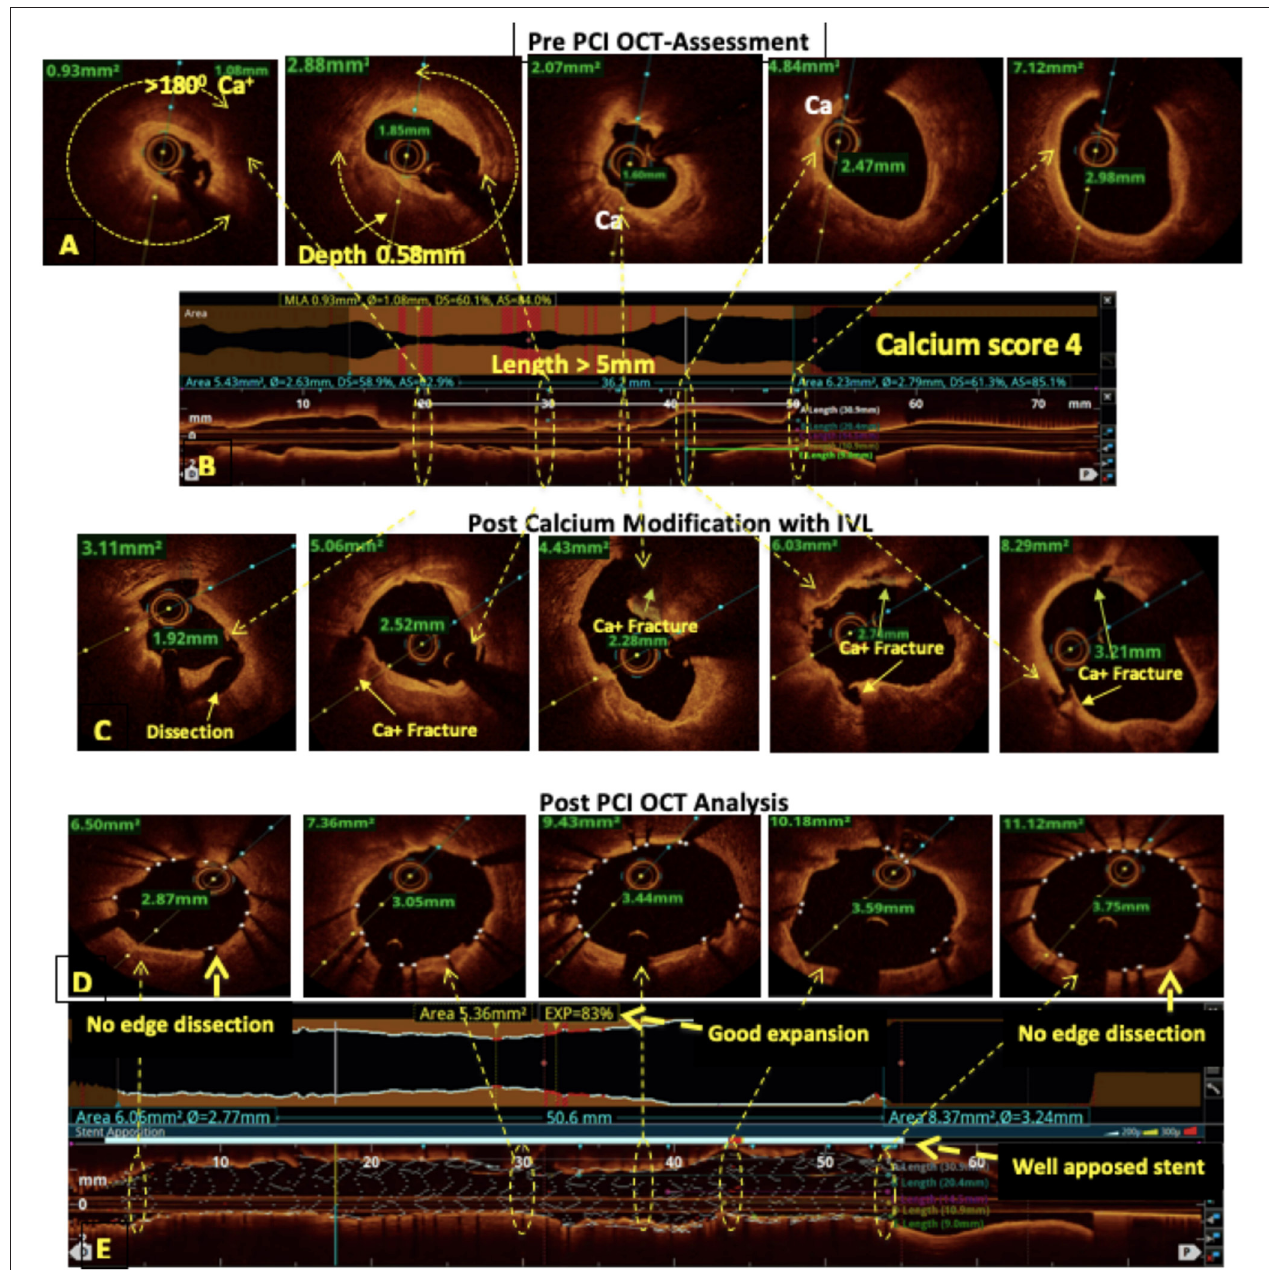
FIGURE 2 | OCT-guided management of calcified left anterior descending (LAD). (A,B) Pre-percutaneous coronary intervention (PCI) assessment showed a heavily calcified LAD with a calcium arc > 180 ◦ , a calcium thickness of 0.58mm, and a length of > 5mm resulting in a calcium score of 4. (C) Fractures in the calcium after modification with intravascular lithotripsy (IVL). (D,E) Post-PCI assessment showed 83% stent expansion, no edge dissection, and a well-apposed